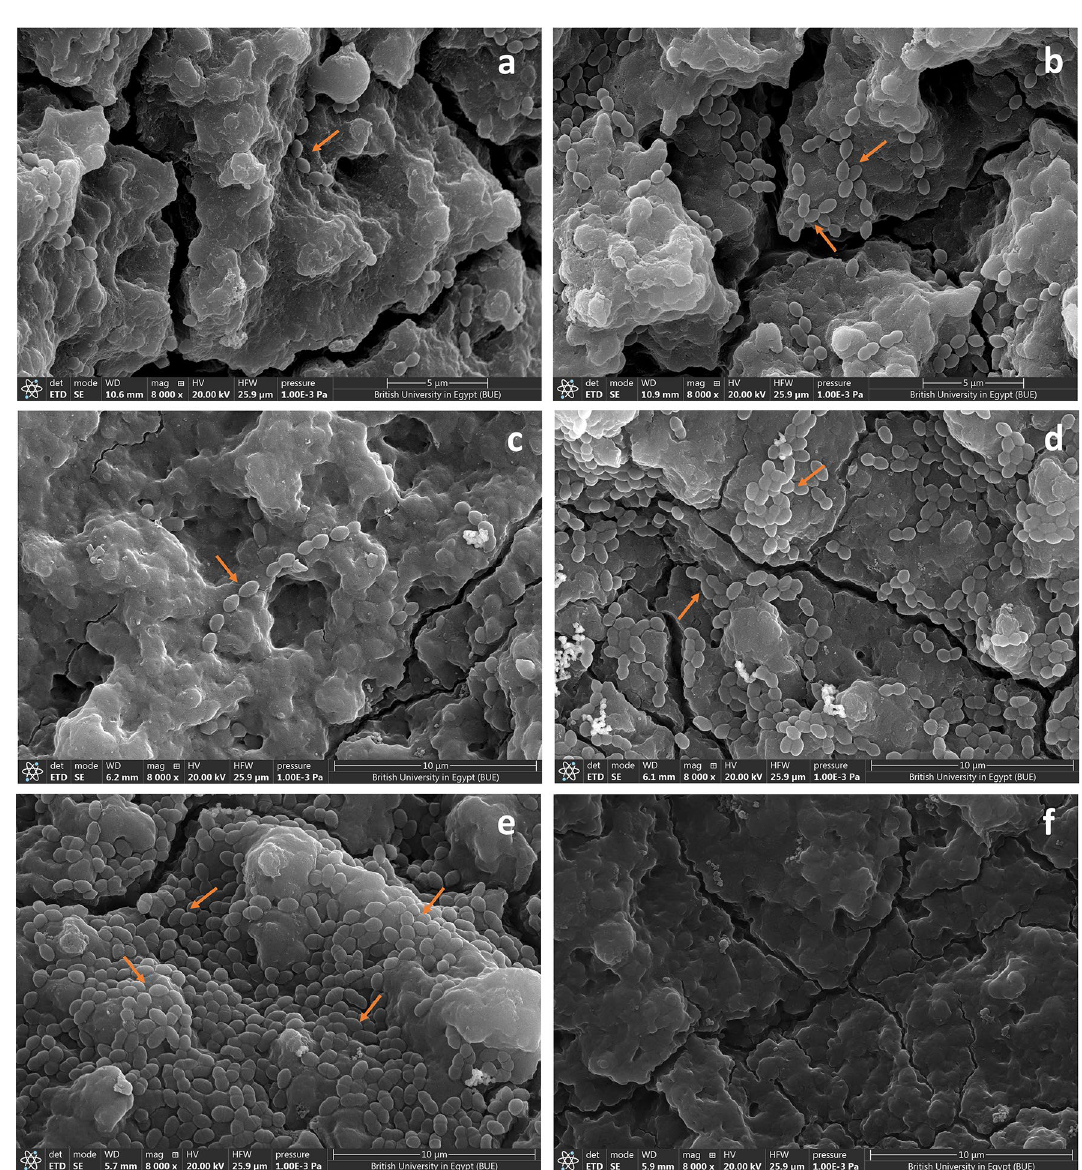
Figure 10. SEM images showing a very few scattered enterococcal cells adhered on the catheter surface treated with ( a ) ½ MIC ginger AgNPs and ( c ) ½ MIC chemical AgNP, and a reduction in the number of the adherent enterococcal cells on catheters treated with ( b ) ¼ MIC ginger AgNPs and ( d ) ¼ MIC chemical AgNPs compared to ( e ) positive control catheter that showed a heavy accumulation of enterococcal cells on the surface of the catheters. ( f ) Catheter free from bacterial cells (negative